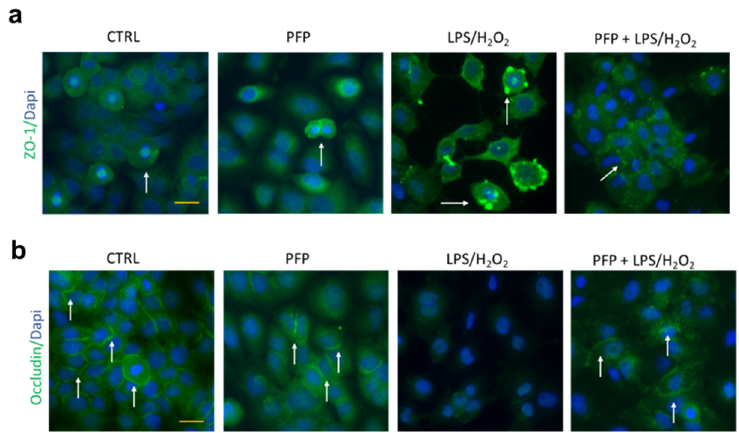
Figure 8. Immunofluorescence staining of ( a ) ZO-1 (green) and ( b ) occludin (green) TJs in HaCaT cells unstimulated (CTRL) or PFP-treated (100 µg/mL), or pre-treated with PFP for 2 h and exposed 3 h to LPS+H 2 O 2 . Dapi (blue) stained cell nuclei. Scale bar: 100 µm.